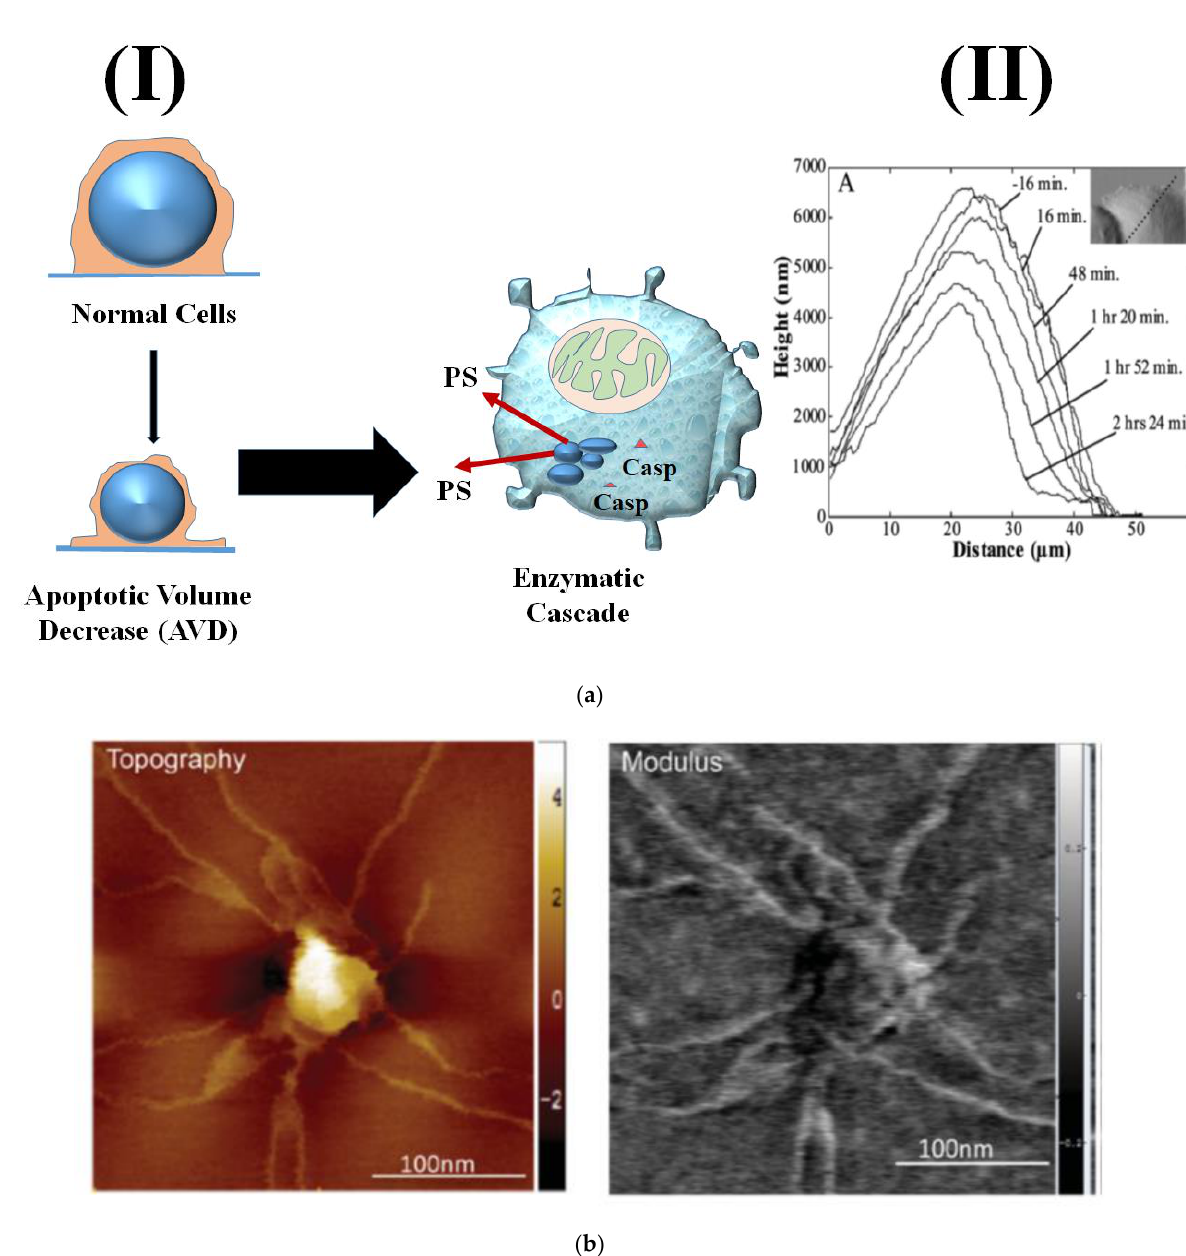
Figure 5. ( a ) Biophysical assessment of apoptotic volume decrease (AVD) in staurosporine treated cancer cells. (I) schematic depiction of biophysical and biochemical changes taking place during apoptosis chronologically. (II) Line scans for AFM images of KB cells exposed to 1 µM staurosporine (STS). Inset shows line scans taken across dashed lines. ( b ) AFM images depict GBM U87-derived exosomes with multiple nano-filamentous structured surface protrusions. Quantitative mapping of several biophysical parameters, including topography (range z = 5 nm) and modulus (z = 2 GPa) are presented.